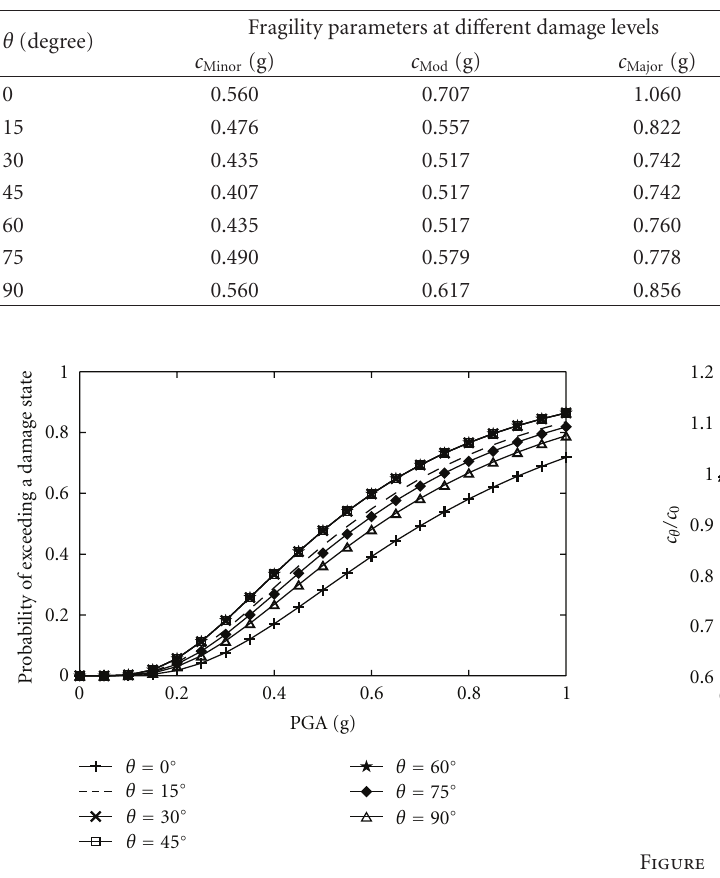
Figure 11: Fragility curves of the example bridge at moderate dam- age state (case II).